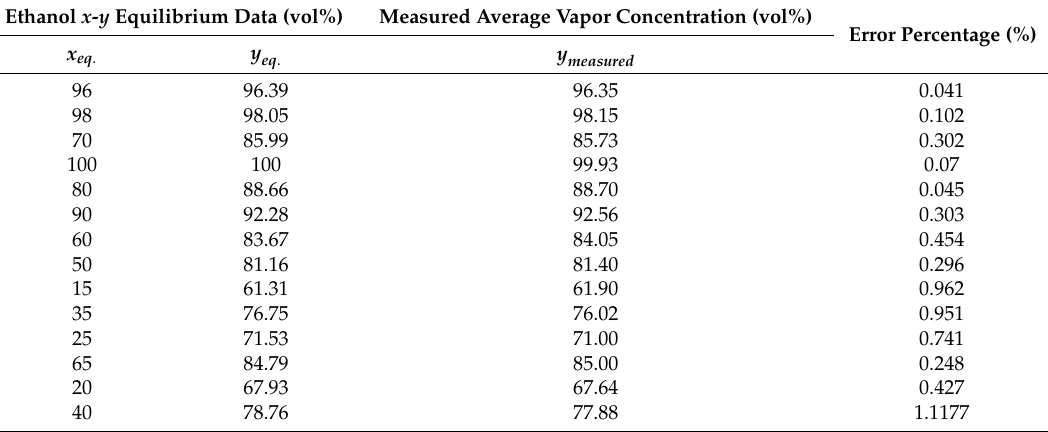
Table 1. Test sample measurements.